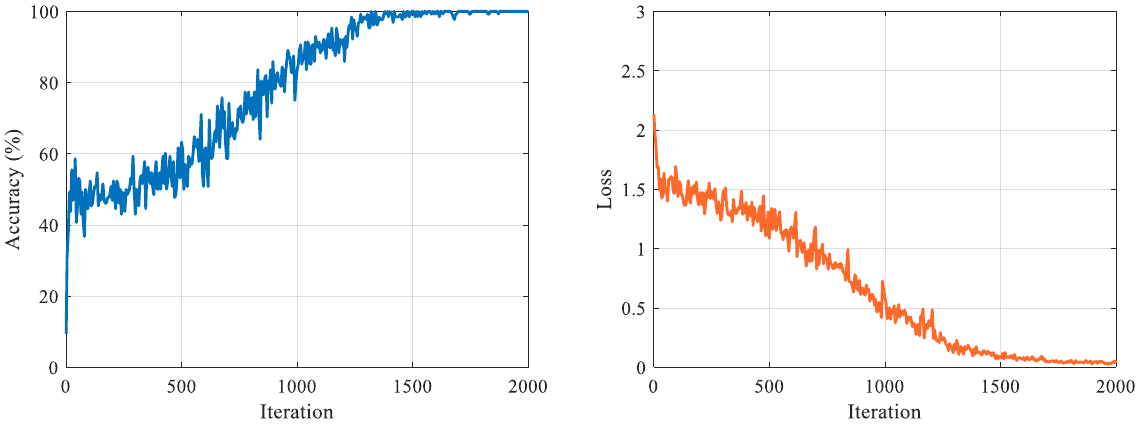
Figure 5. Training accuracy and loss graphs of the R-CNN+LSTM model.